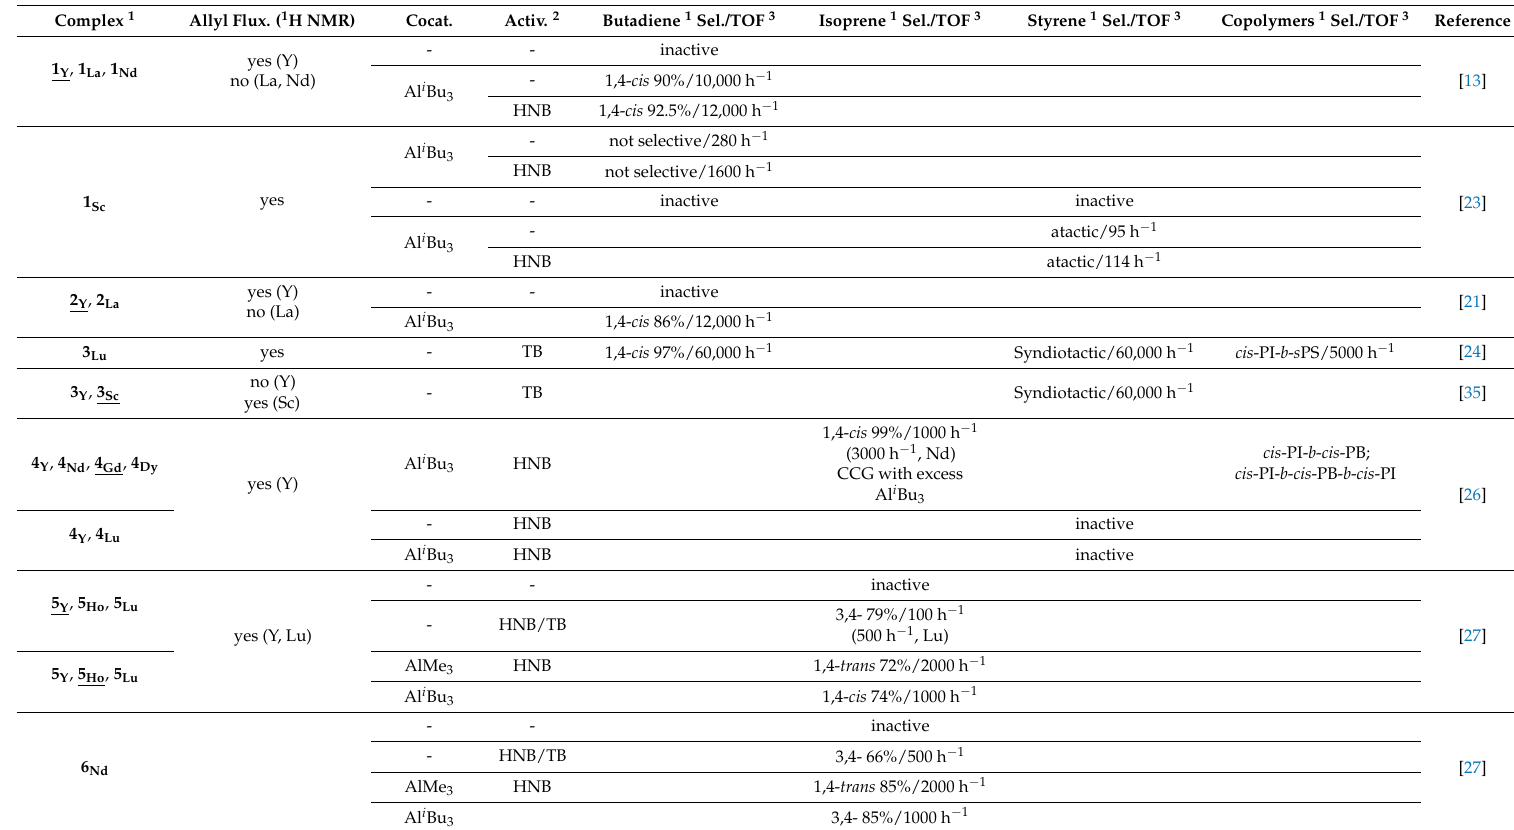
Table 1. Summary of complexes and their